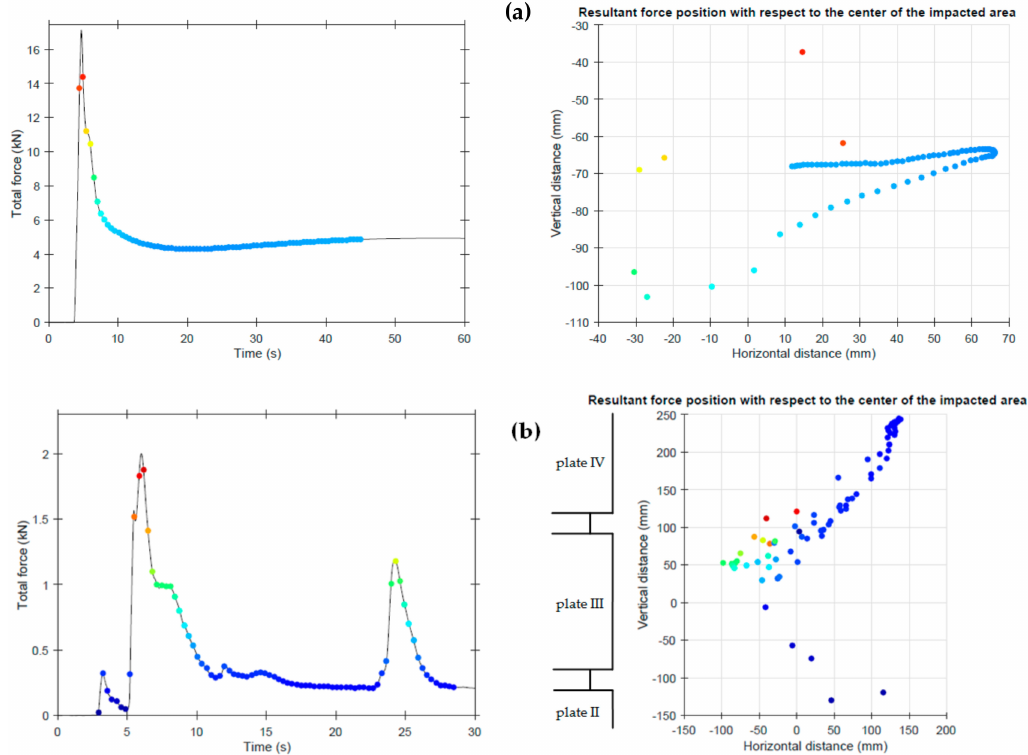
Figure 18. Center of forces for the ( a ) 30 April 2013 and ( b ) 20 January 2014 avalanches (data averaged over 0.2 s). The colored dots help the reader to follow the time evolution from plot ( a ), where the time is on the abscissa, to plot ( b ), where the time is not